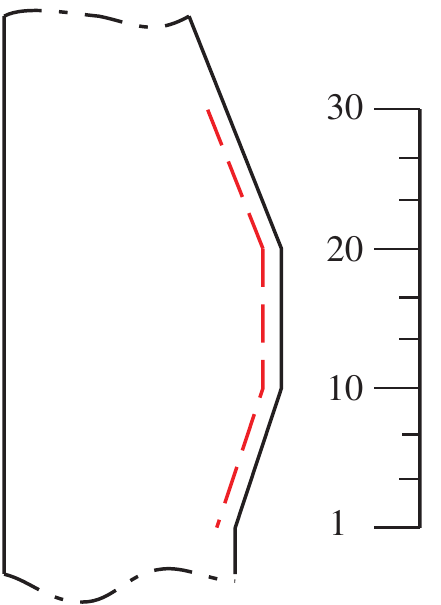
Figure 2: Schematic diagram of the sampling points of the gas flow